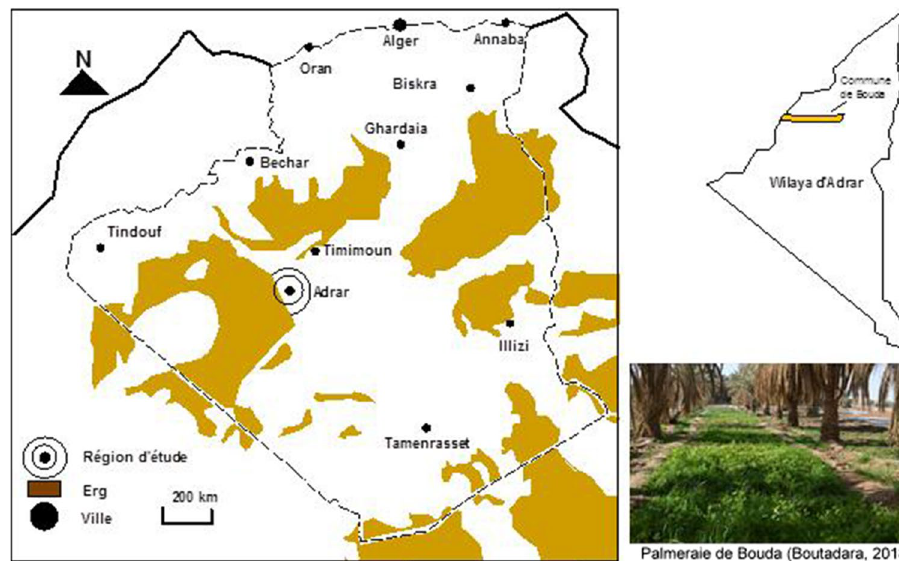
Fig. 1 Geographical location of the study area. (own elabora- tion)